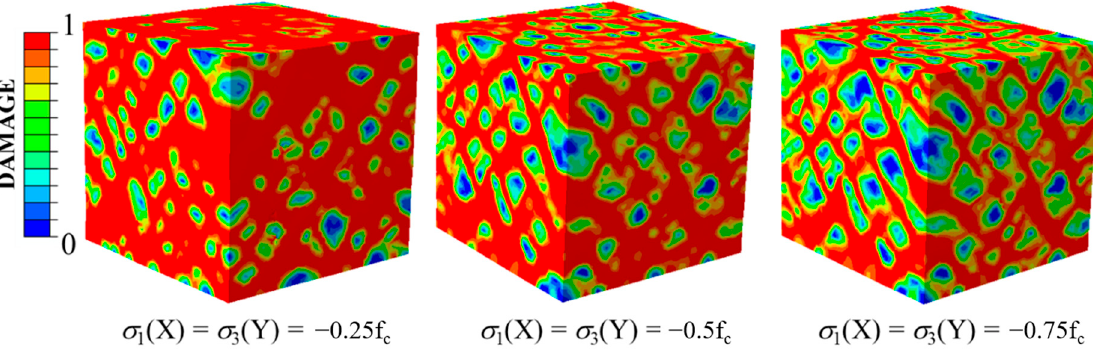
Figure 11. Failure patterns with different compressive stress when ε = 0.01.